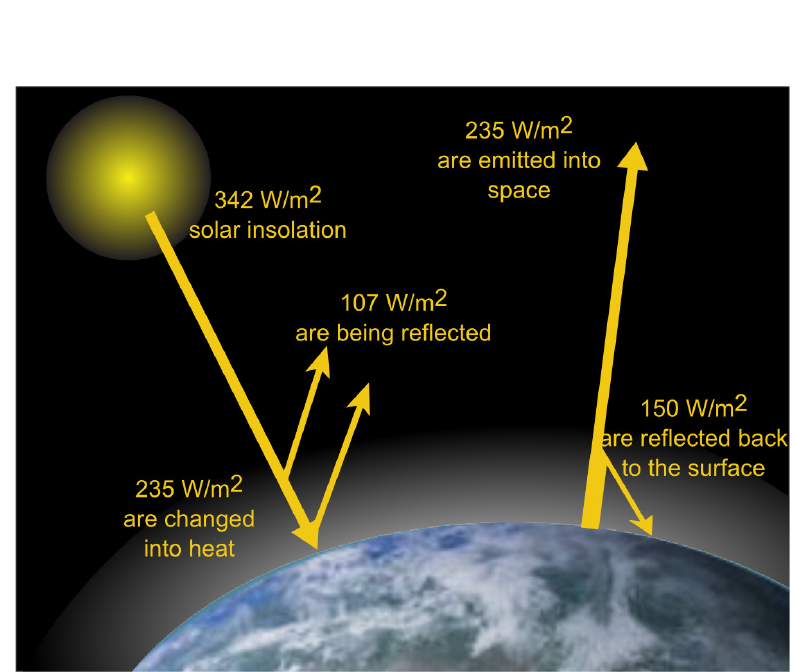
Fig. 1. – The average energy budget of the